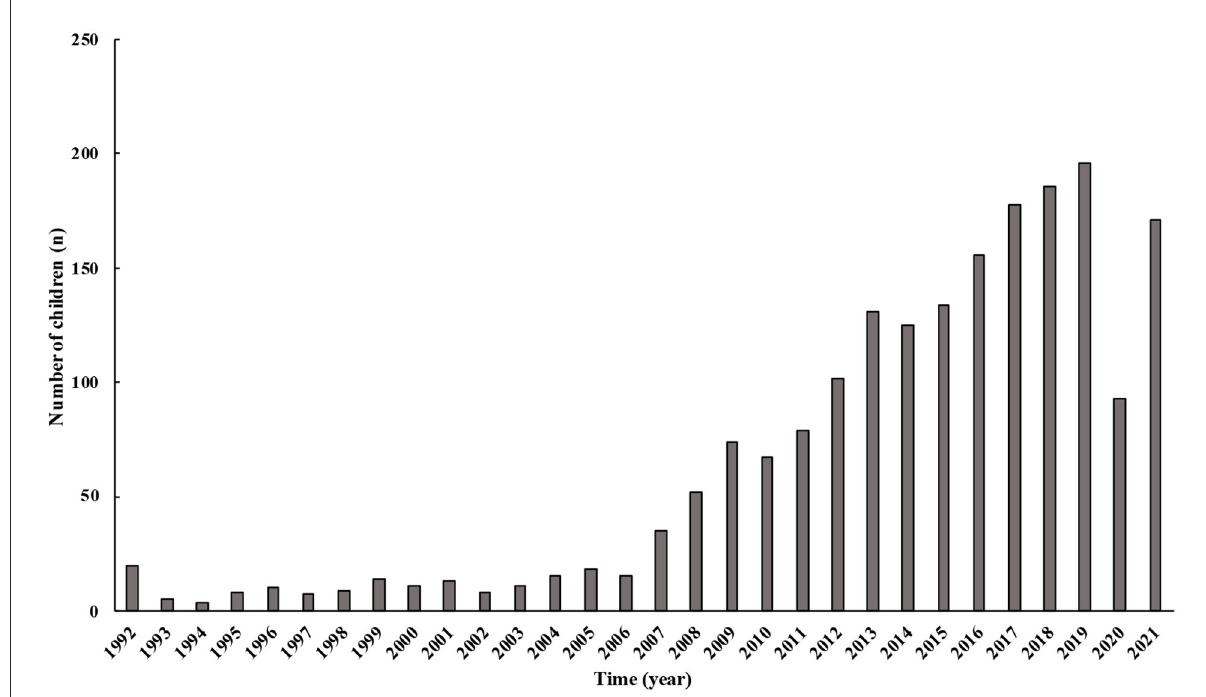
FIGURE1 Changes in the number of children with syncope over years. From 1992 to 2021, the number of patients admitted to our center in China gradually increased. The number of patients after 2020 was progressively lower than before.